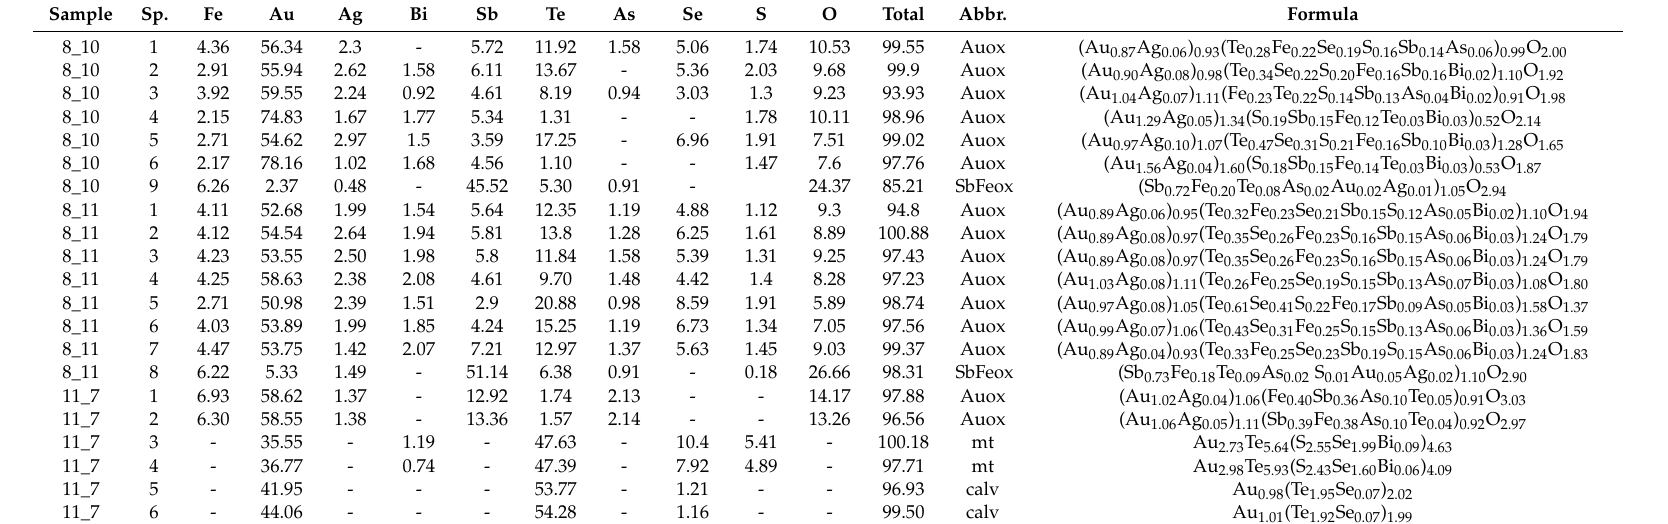
Table 7. Compositions of Au-(Te,Fe,Se,Sb,Bi,S,As) and Sb-(Fe,Te,As,S,Au,Ag) oxides, maletoyvayamite and calaverite (in wt %) shown in Figure 8.